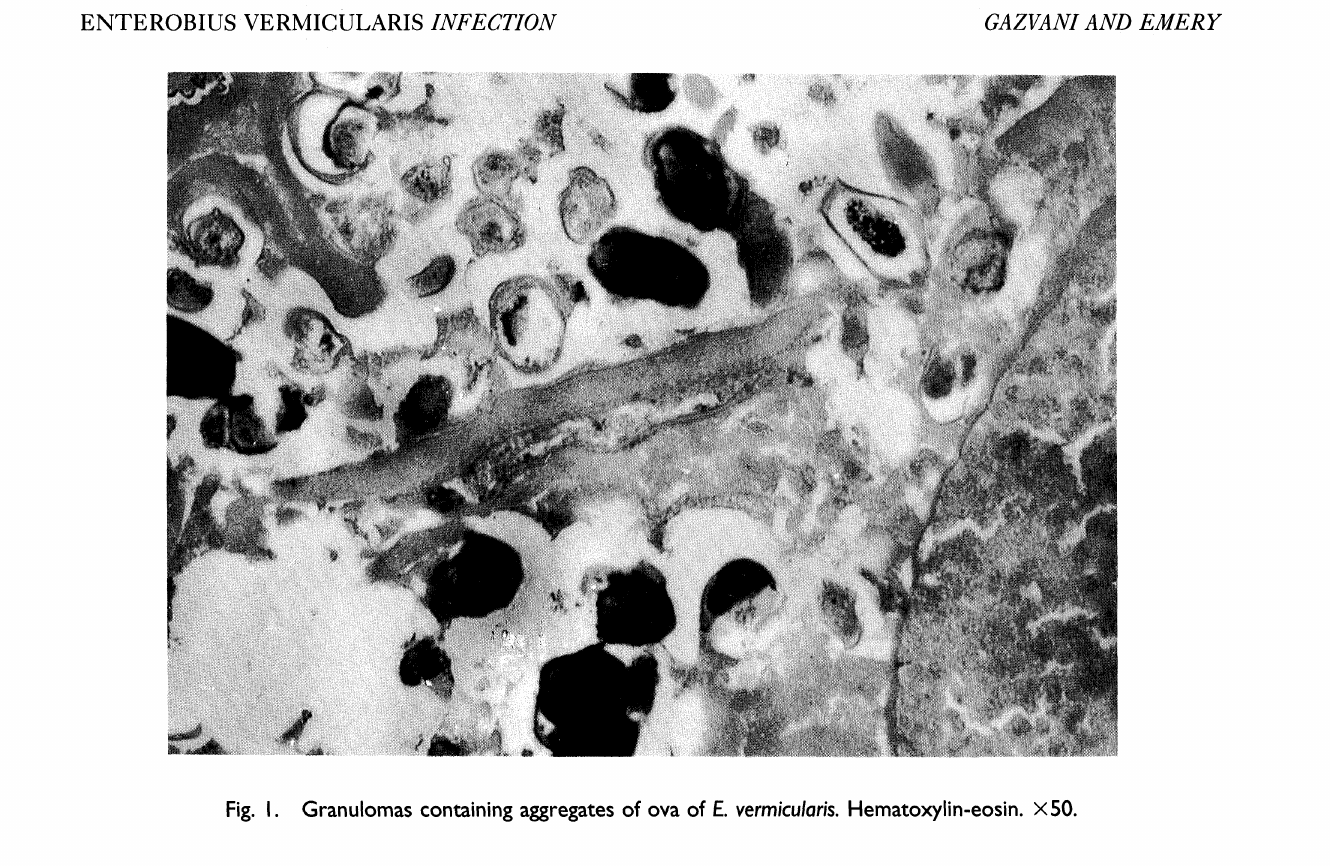
Fig. I. Granulomas containing aggregates of ova of E. vermicularis. Hematoxylin-eosin.